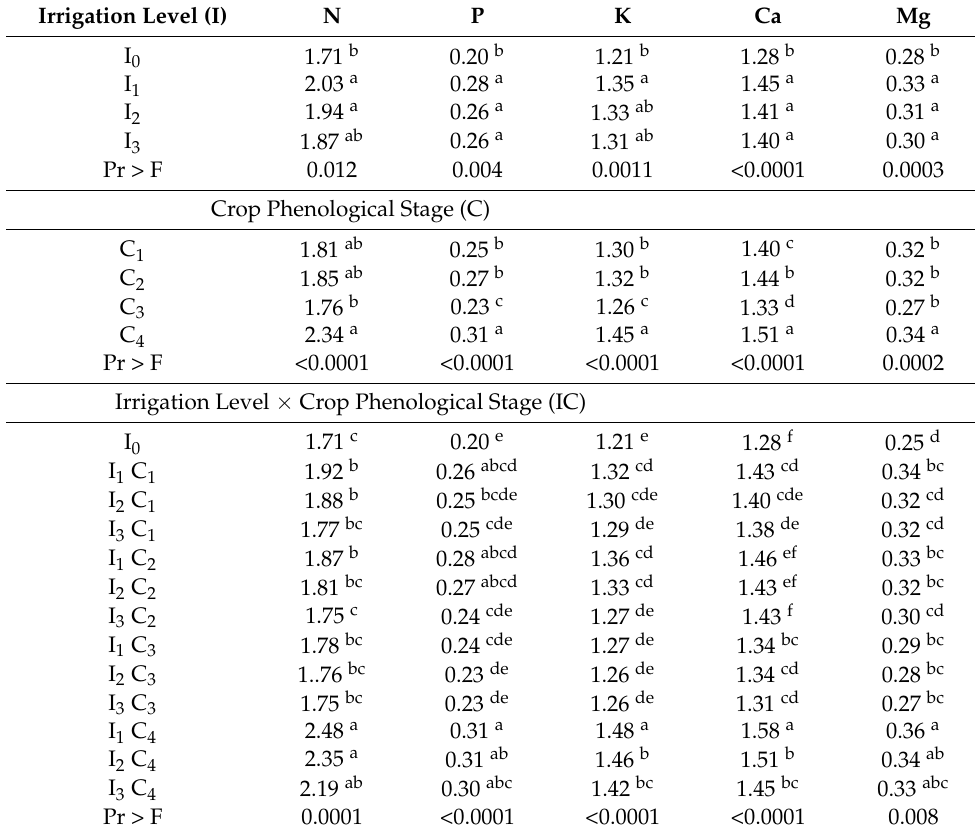
Table 8. Effect of different irrigation levels at various crop phenological stages on leaf nutrient content. Irrigation Level